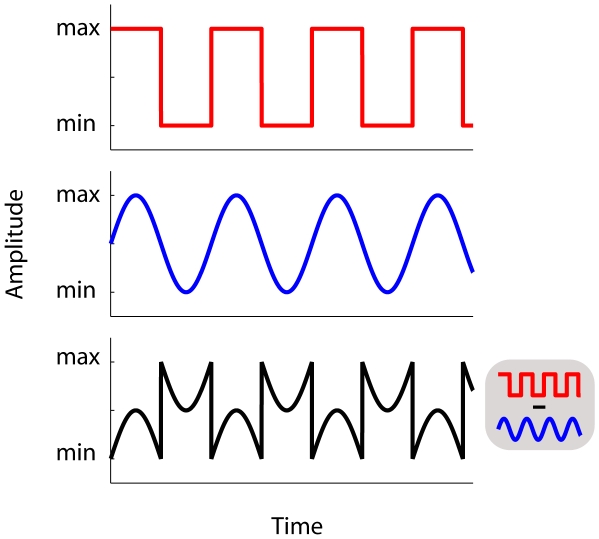
Stimuli used in Experiment 4.The difference-wave (lower panel) reflects the difference between the square- and sine-wave modulations. See Movie S4 for an example difference-wave trial.